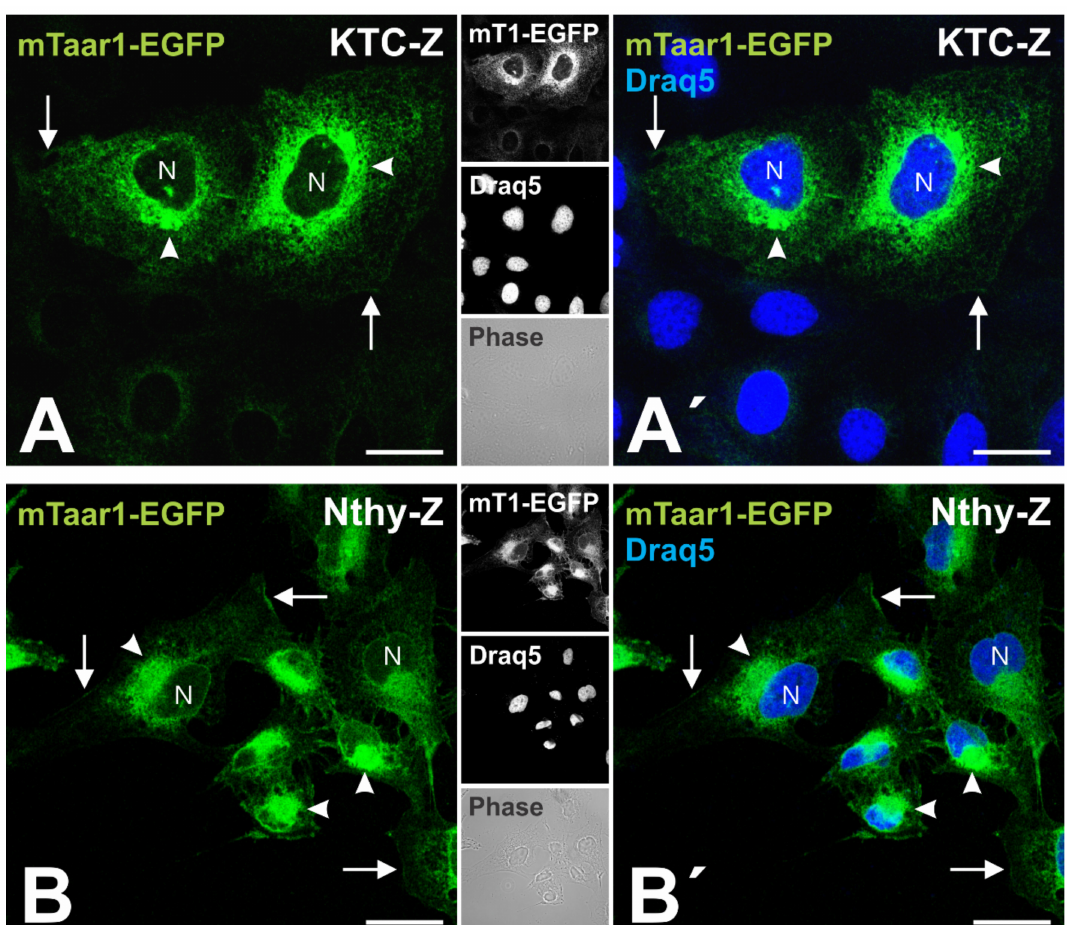
Figure 4. mTaar1-EGFP is predominantly localized in the perinuclear regions of KTC-Z and Nthy-Z cells at 37 ◦ C. mTaar1- EGFP signal can be seen outlining the nuclei (N) and spread out in a reticular pattern, thus, resembling the ER in both KTC-Z ( A , A’ ) and Nthy-Z ( B , B’ ) cells. Additionally, mTaar1-EGFP can be seen in the Golgi apparatus (arrowheads). Occasionally, mTaar1-EGFP signal became detectable on the surface of KTC-Z and Nthy-Z cells (arrows). Note that the focal plane of the confocal sections is in the median portion of the cells, which does not allow visualization of cilia. Single channel fluorescence ( A , B ) and merged fluorescence micrographs ( A’ , B’ ) for mTaar1-EGFP (green) and Draq5™ as nuclear counter-stain (blue) are shown along with single channel fluorescence and corresponding phase contrast micrographs in the right panels of A and B , respectively, as indicated. Scale bars represent 20 µ